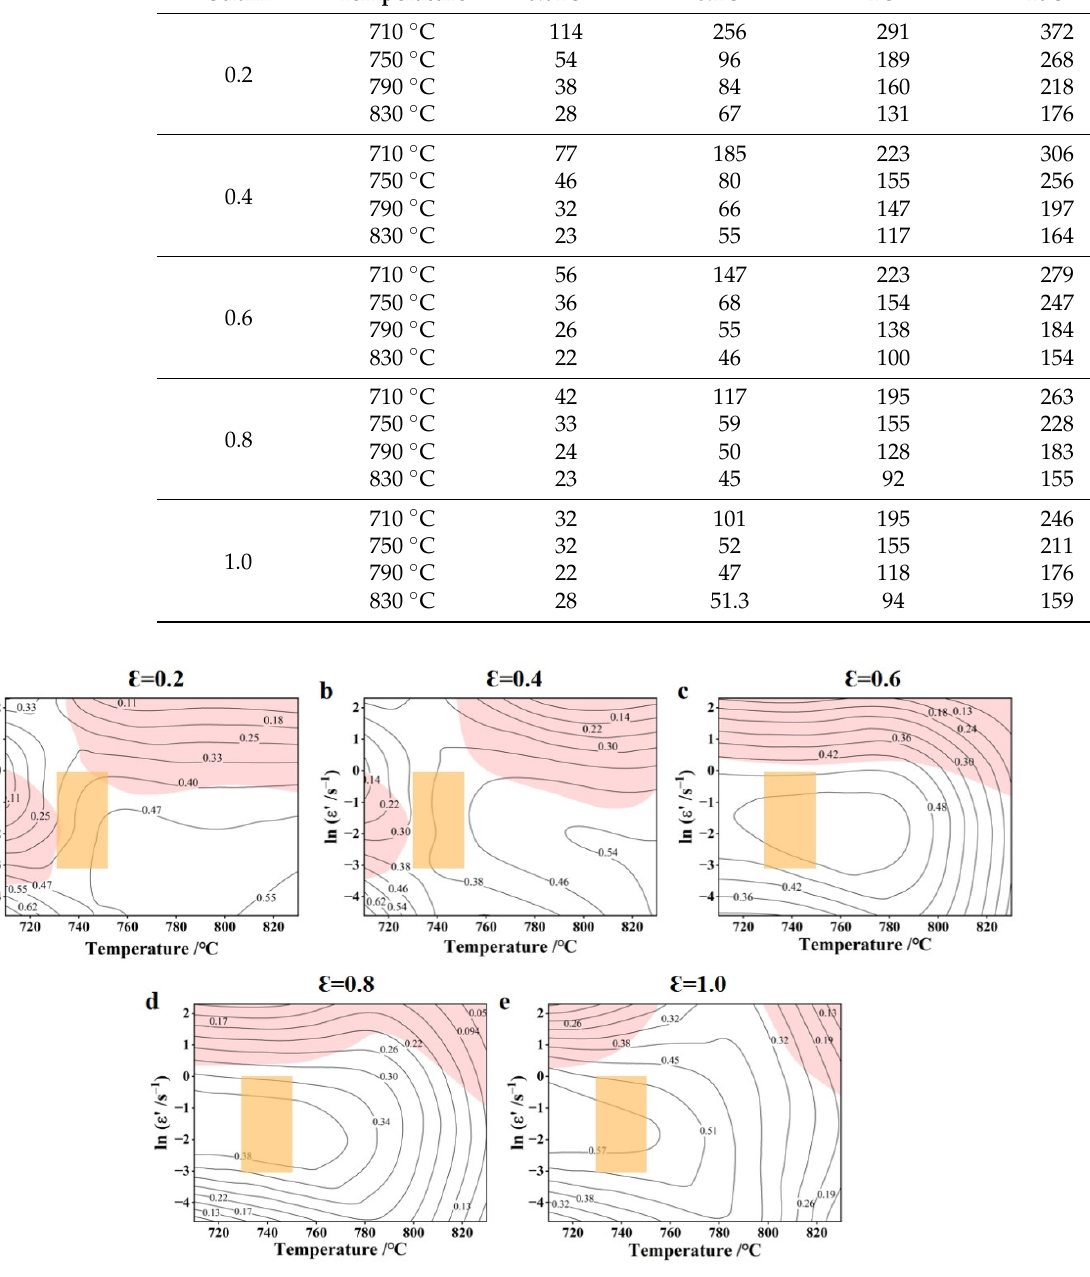
Figure 4. Processing map of the Ti15Zr5Cu alloy at different strain rates. ( a ) ε = 0.2; ( b ) ε = 0.4; ( c ) ε = 0.6; ( d ) ε = 0.8; ( e ) ε = 1.0. The optimal deformation window is marked in orange.